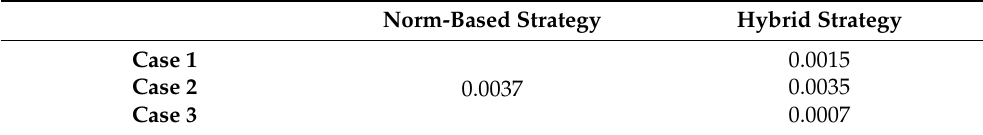
Table 1. Comparison of Fuel Consumption.